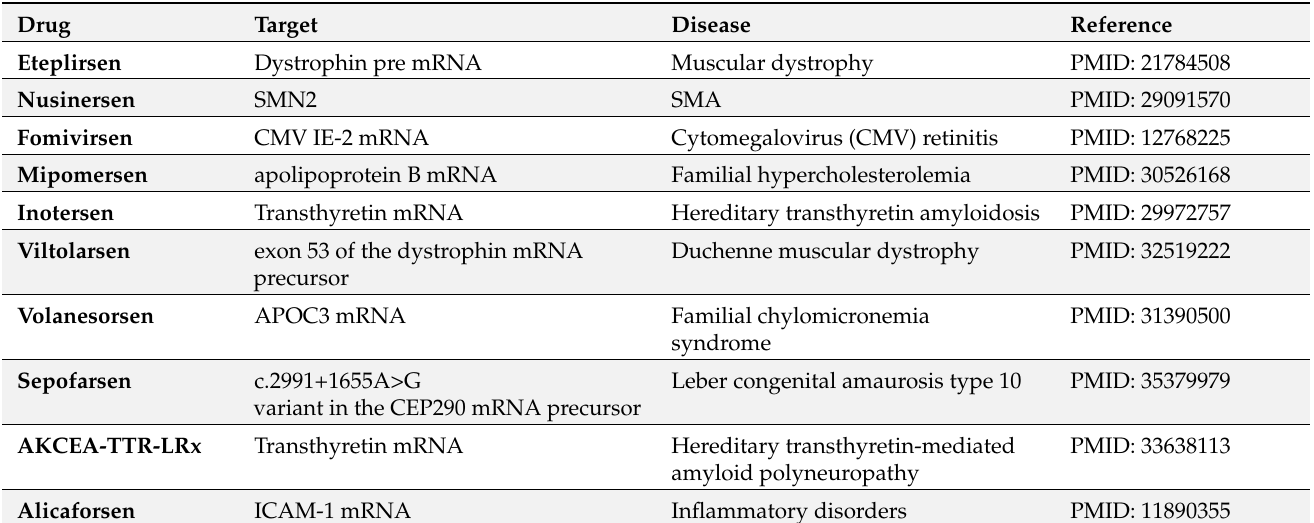
Table 2. List of RNA ASOs used in clinic or under clinical trials for different diseases